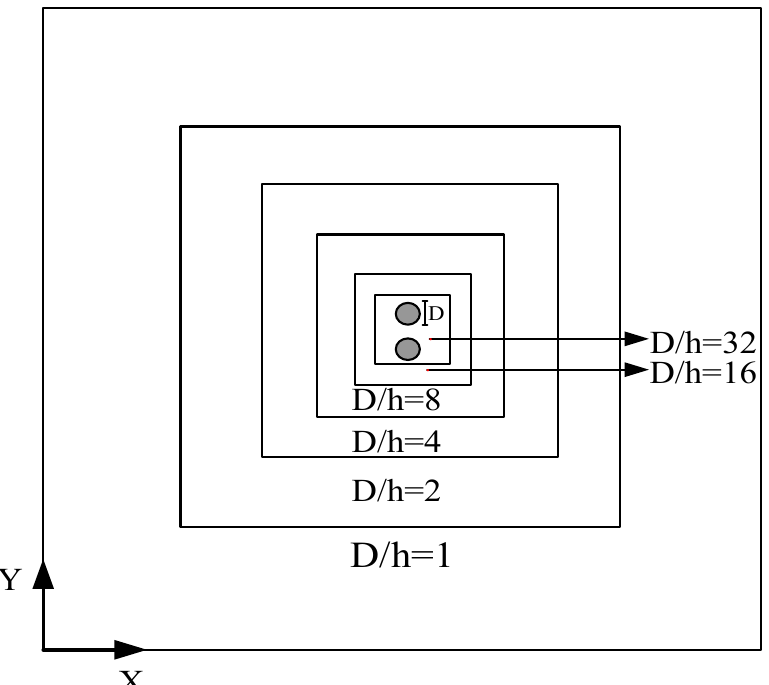
Figure 3. Mesh refinement scheme.